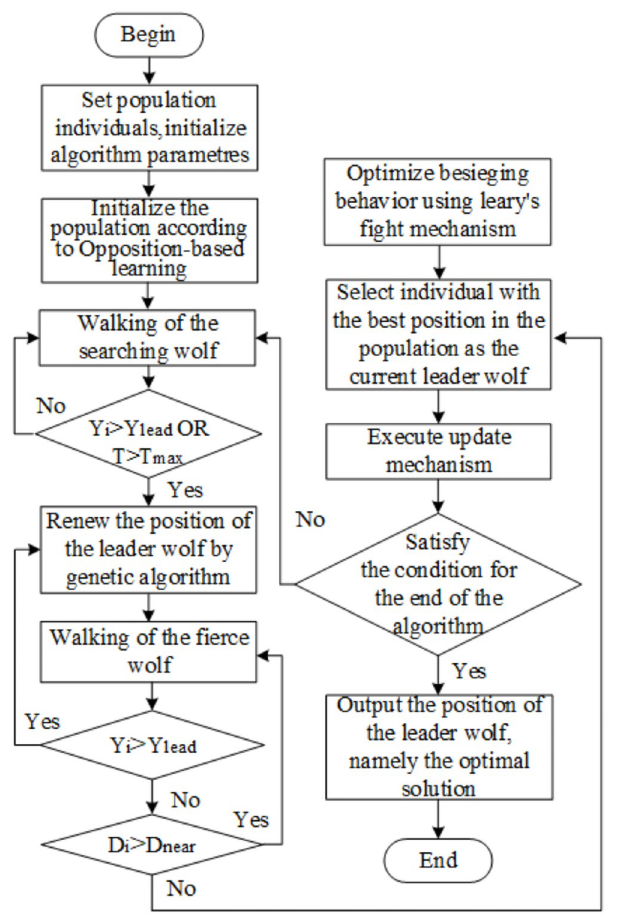
Fig 1. Flow chart of this